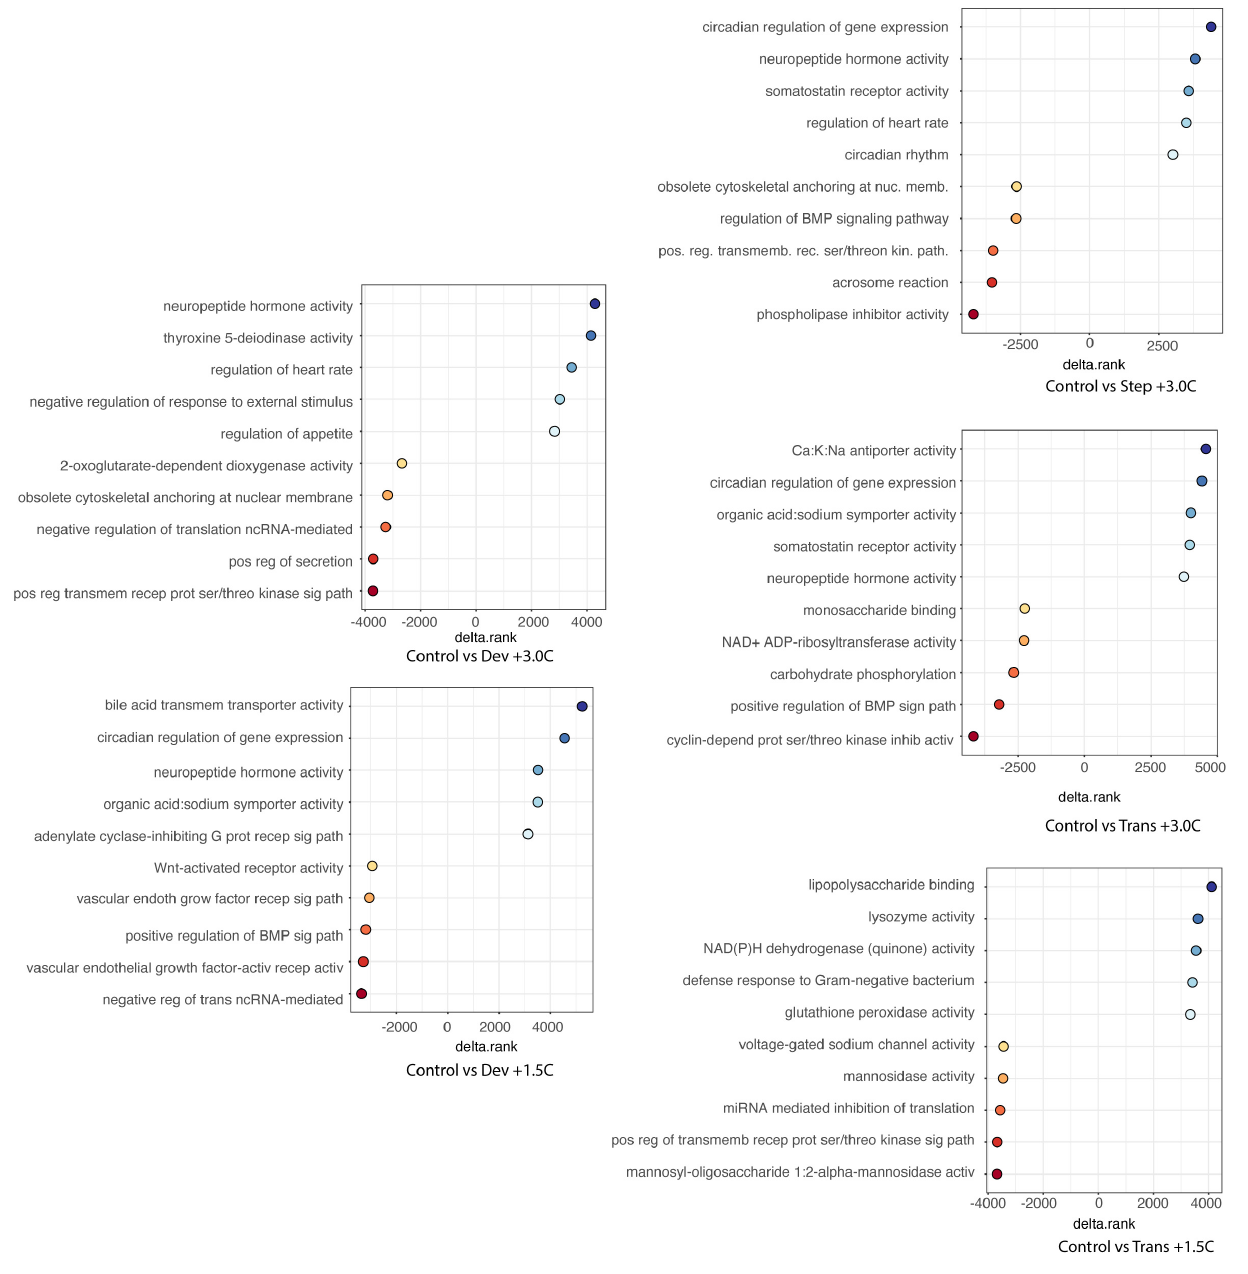
GO terms upregulated in F2 Developmental + 1.5 ◦ C